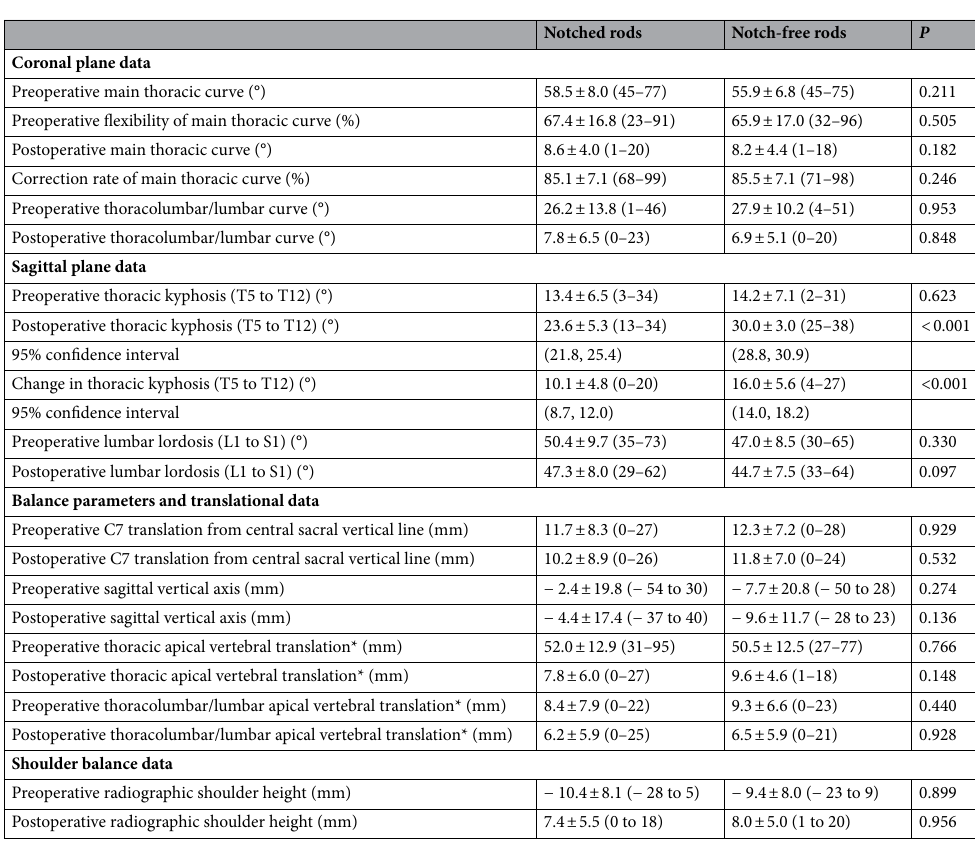
Table 2. Radiographic parameters. All data expressed as means ± SD and range. Mann–Whitney U test. *Distance between the geometric center of the apical vertebrae and the C7 plumb line or the center sacral vertical